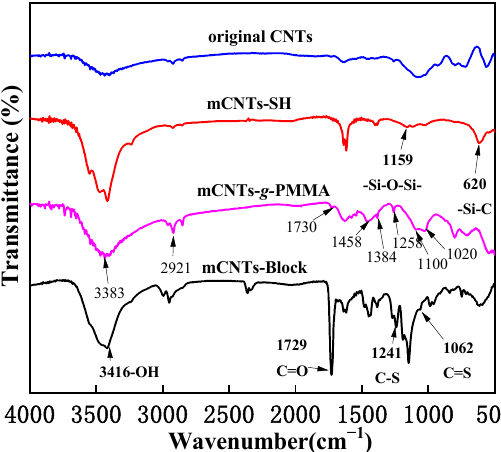
Figure 2. FITR spectra of magnetically functionalized CNTs. Figure 3 shows the XRD patterns of mCNTs- g -block, mCNTs-SH, mCNTs, and Fe 3 O 4 particle samples. The Fe 3 O 4 particles present peaks at 31.70°, 35.44°, 43.10°, 53.56°, 57.10°, and 62.66°, corresponding to the diffraction peaks of Fe 3 O 4 at (200), (311), (400), (422), (333), and (440), respectively [2]. As these Fe 3 O 4 particles are deposited on the CNTs, the characteristic peaks still keep in the samples, even after grafted single and diblock chains.